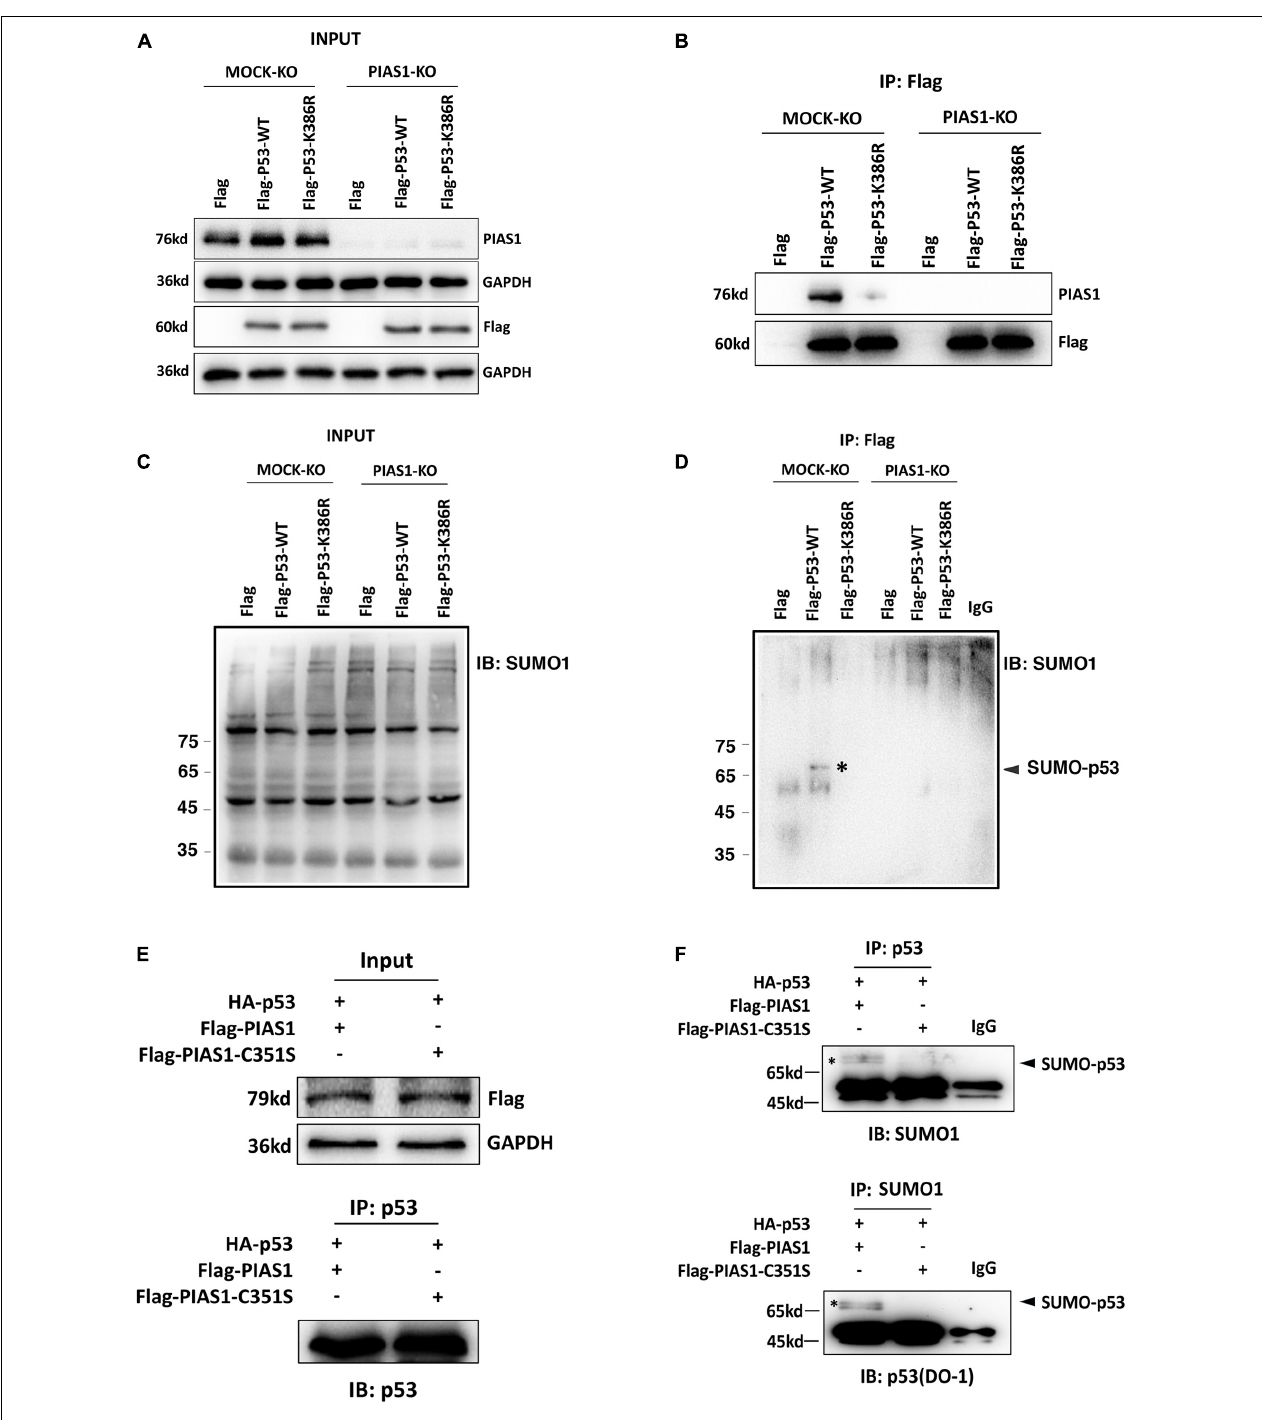
FIGURE 3 | PIAS1 mediates p53 sumoylation in lens epithelial cells at the K386 residue. (A–D) MOCK-KO and PIAS1-KO cells were transfected with Flag, Flag-p53-WT, or Flag-p53-K386R as indicated. Forty-eight hours after transfection, whole-cell lysates were blotted (IB) with anti-PIAS1, anti-Flag antibodies (A) , and anti-SUMO1 antibody (C) . The cell lysates were immunoprecipitated (IP) with anti-Flag antibody, followed by blotting (IB) with anti-PIAS1, anti-Flag antibodies (B) , and anti-SUMO1 antibody (D) . The SUMO1-p53 conjugated band was detected (labeled with ∗ ). (E,F) MOCK-KO and PIAS1-KO cells were co-transfected with HA-p53 and Flag-PIAS1 or Flag-PIAS1-C351S plasmids as indicated. Forty-eight hours after transfection, whole-cell lysates were blotted (IB) with anti-Flag antibody (E , top ) . The cell lysates were immunoprecipitated (IP) with anti-p53 antibody, followed by blotting (IB) with anti-p53 (DO-1) antibody (E , bottom ) and anti-SUMO1 antibody (F , top ) . In turn, the cell lysates were immunoprecipitated (IP) with anti-SUMO1 antibody, followed by blotting (IB) with anti-p53 (DO-1) antibody (F , bottom ) . The sumoylated p53 was detected (labeled with ∗ ). The IP experiments were conducted in the presence of a desumoylation inhibitor, 20 mM NEM.